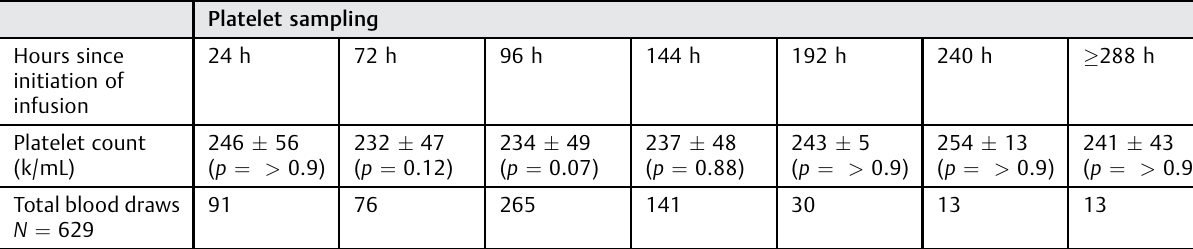
Table 2 Platelet count values by time from initial heparin exposure Platelet